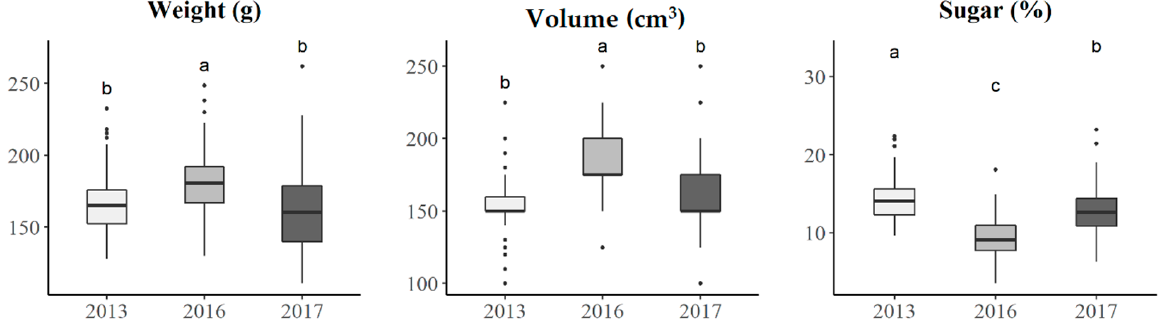
Figure 3. Fruit parameters (weight, volume, and sugar content) measured in the three study years (2013, 2016, and 2017). All treatments are considered. Lowercase letters represent significant differences among the study years (Tukey’s test p < 0.05).